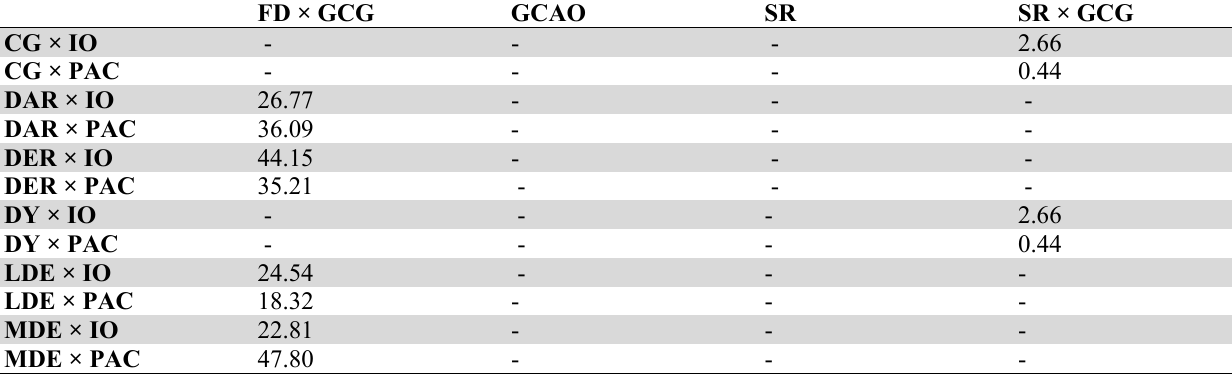
Outer Model Testing Results